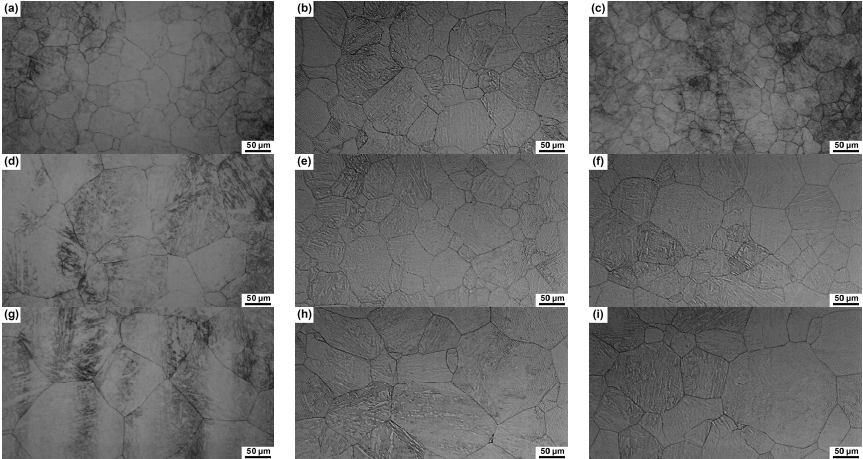
Figure 6. Grain morphology at different peak temperatures and t 8/5 time: ( a ) 1200 °C, t 8/5 = 20 s, ( b ) 1200 °C, t 8/5 = 50 s, ( c ) 1200 °C, t 8/5 = 100 s, ( d ) 1250 °C, t 8/5 = 20 s, ( e ) 1250 °C, t 8/5 = 50 s, ( f ) 1250 °C, t 8/5 = 100 s, ( g ) 1300 °C, t 8/5 = 20 s, ( h ) 1300 °C, t 8/5 = 50 s, ( i ) 1300 °C, t 8/5 = 100 s.